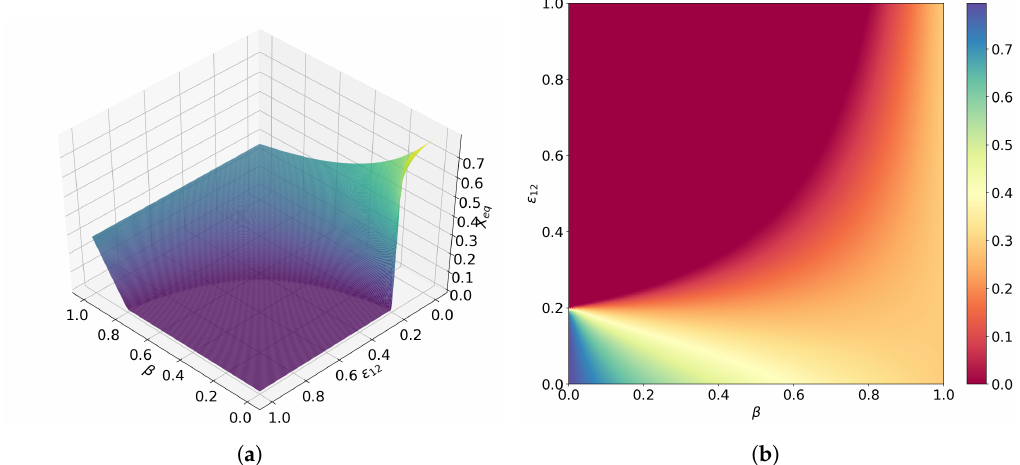
Figure 7. Two-parameter bifurcation diagram representing x ∗ heat map ( b ) for a more intuitive understanding. Parameters used: ε = 0.2, η k =